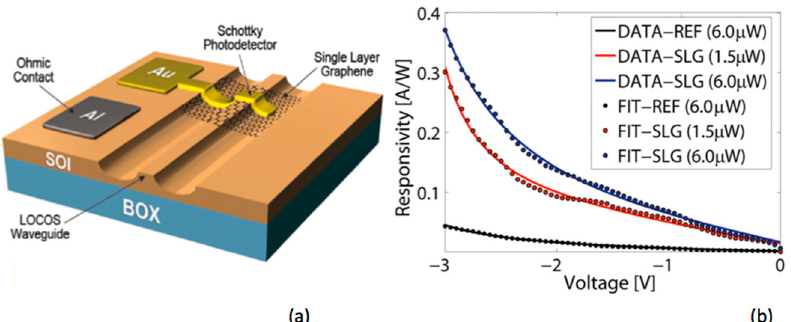
Figure 5. ( a ) Scketch of the Graphene/Si Schottky photodetectors (PD) investigated in Goykhman [36]. ( b ) Responsivity of Graphene/Si Schottky PDs and Metal − Si PDs (for comparison). Solid lines are the curve fitting obtained by taking into account a combined avalanche multiplication and thermo field emission effect. Reprinted with permission from (Goykhman, Sassi, Desiatov, Mazurski, Milana, de Fazio, Eiden, Khurgin, Shappir, Levy, Ferrari. Integrated, Silicon–Graphene Plasmonic Schottky